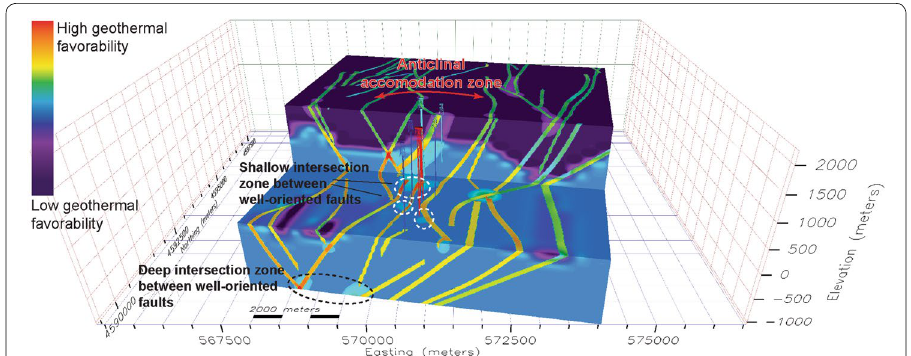
Fig. 12 3D geothermal potential map of the Tuscarora geothermal system. Warm colors, which are associated with the collocation of favorably oriented fault segments, high fault intersection/fault termination, and the Paleozoic basement section, indicate high geothermal potential. The dashed outlined areas of high geothermal potential are interpreted as the most likely locations for geothermal fluid upwelling. Geothermal production wells (red) and injection wells (dark blue are the proximal, light blue are the distal injection wells) are shown